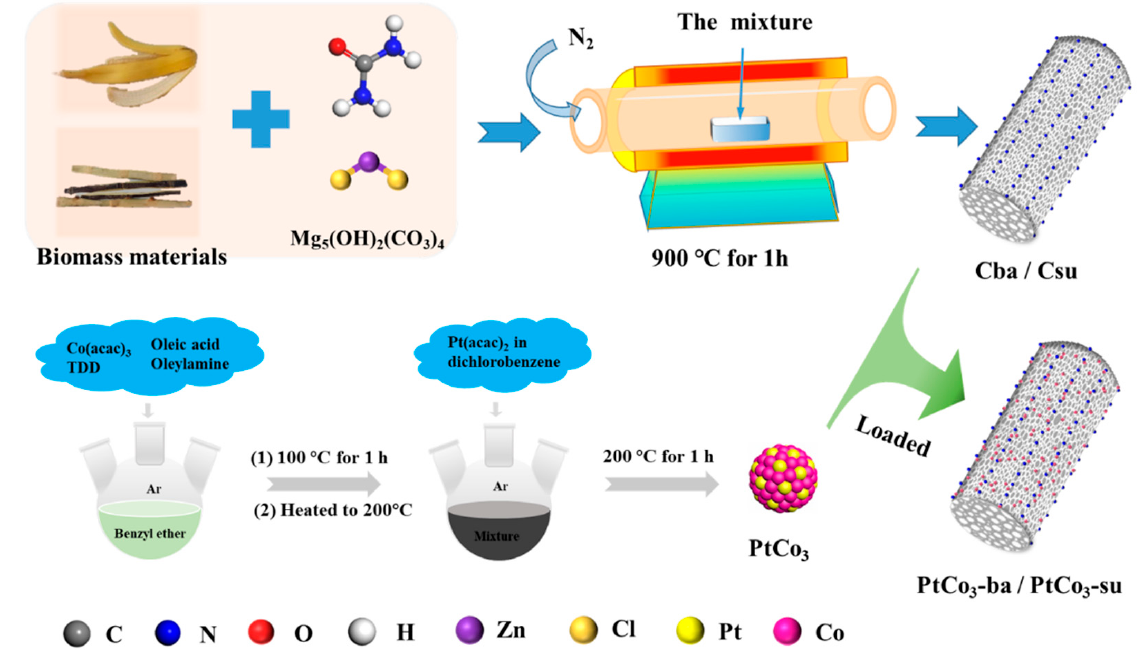
Figure 1. Diagram of PtCo 3 catalyst synthesis method.